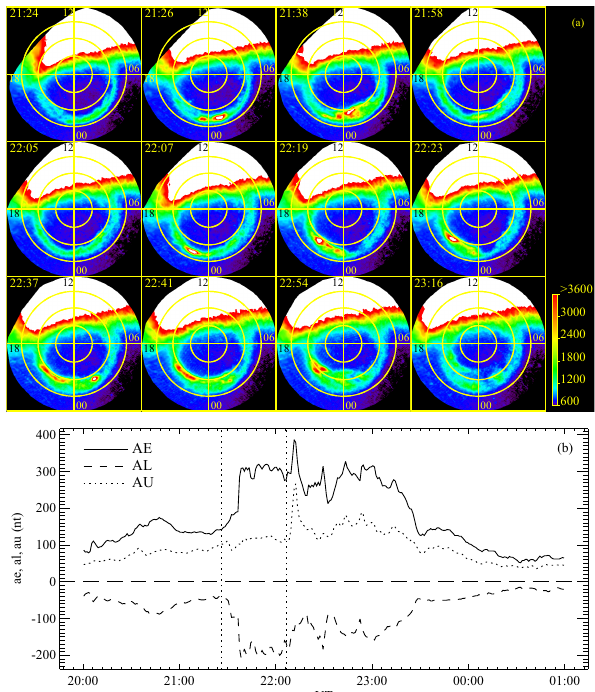
Fig. 3. (a) Polar view of the WIC count rate obtained on 17 Febru- ary 2002, in magnetic coordinates (noon at top, concentric circles every 10 Deg MLAT). The bright dayglow appears as white in the upper part of each image. (b) Auroral AE, AL and AU indices recorded on 17 and 18 February 2002. The vertical dotted lines indicate substorm